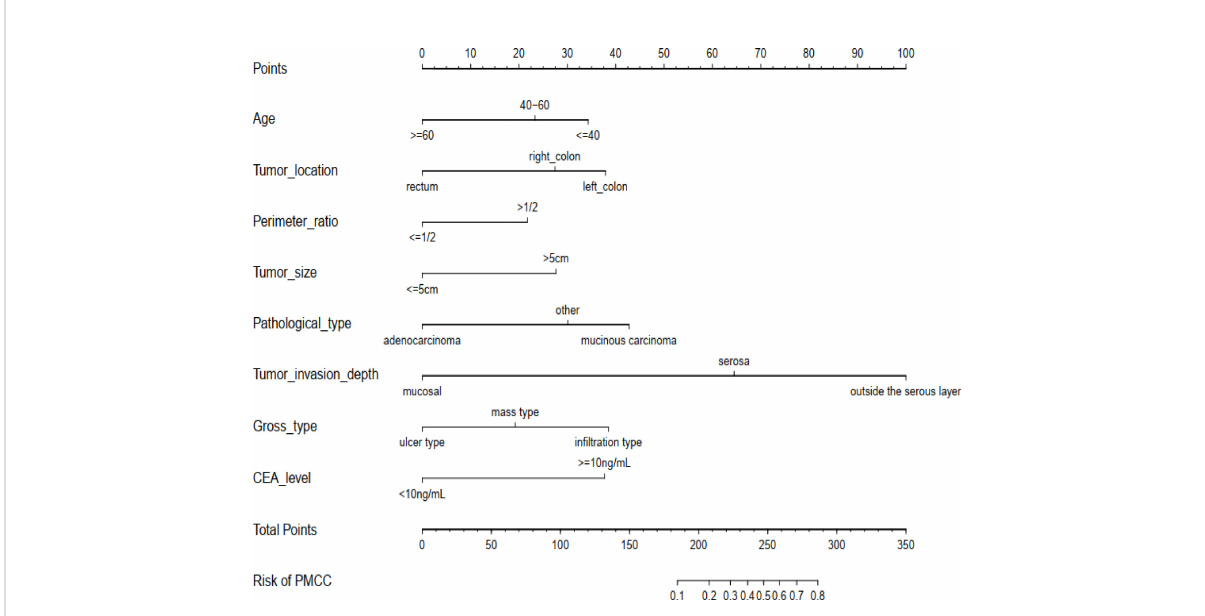
FIGURE 2 The newly developed PMCC prediction nomogram. PMCC, peritoneal metastasis of colorectal cancer; CEA, carcinoembryonic